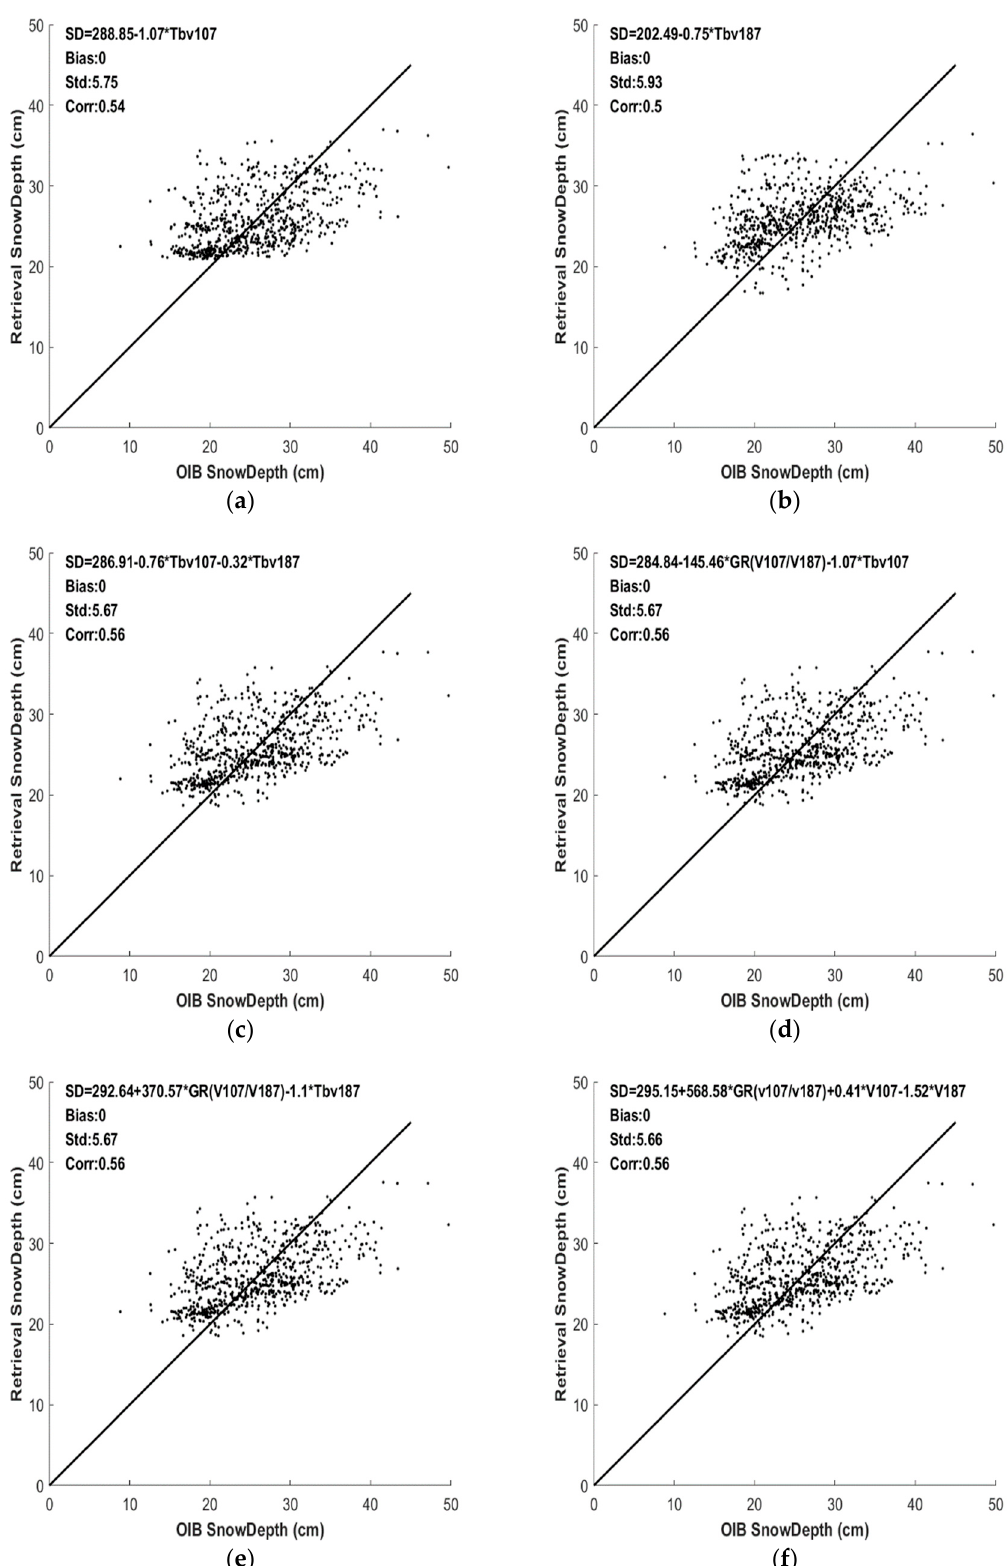
Figure 12. Fitting results on MYI. ( a – f ) correspond to Equations (6)–(11), respectively. Similar to the algorithm development for FYI, the above algorithms were used to calculate the snow depths corresponding to the TBs from calibration dataset. The retrieved